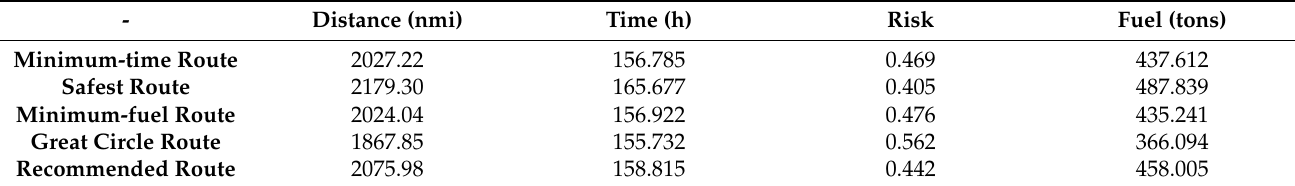
Figure 9. Ship route optimization results under severe conditions: ( a ) the Pareto optimal solution set of the multicriteria route; ( b ) the Pareto optimal frontier solution; ( c ) great circle route and four optimized routes; and ( d ) recommended routes. Table 6. Objective function values of five routes in severe